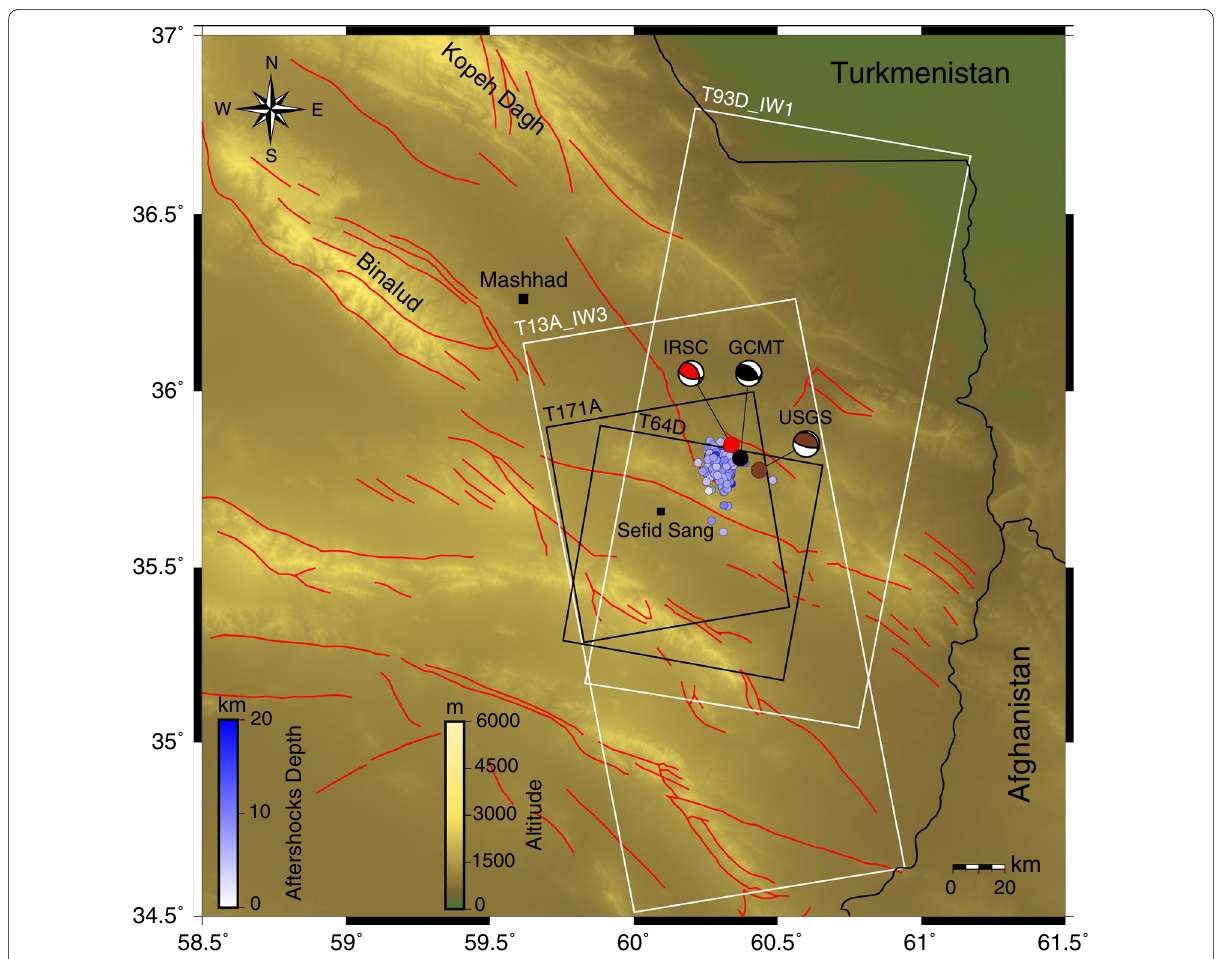
Fig. 1 Location of the 2017 Sefid Sang earthquake in northeastern Iran. Colored dots represent the aftershocks with magnitude larger than 2.5 located by the Iranian Seismological Center (IRSC) between 5 April 2017 and 31 December 2018, plotted together with the focal mechanisms of the mainshock determined by different organizations. The red lines represent faults from the USGS World Energy Project (https ://catal og.data.gov/datas et/major -fault s-in-iran-flt2c g). The cities of Mashhad and Sefid Sang are also indicated. Black boxes outline the used ascending and descending ALOS-2 SAR frames and white boxes outline the used ascending and descending Sentinel-1A SAR